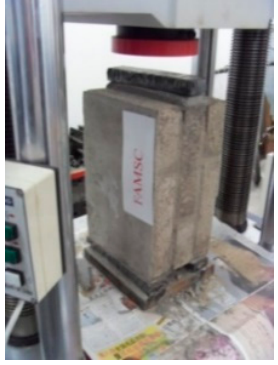
Figure 6. The test loading of the shear specimen.